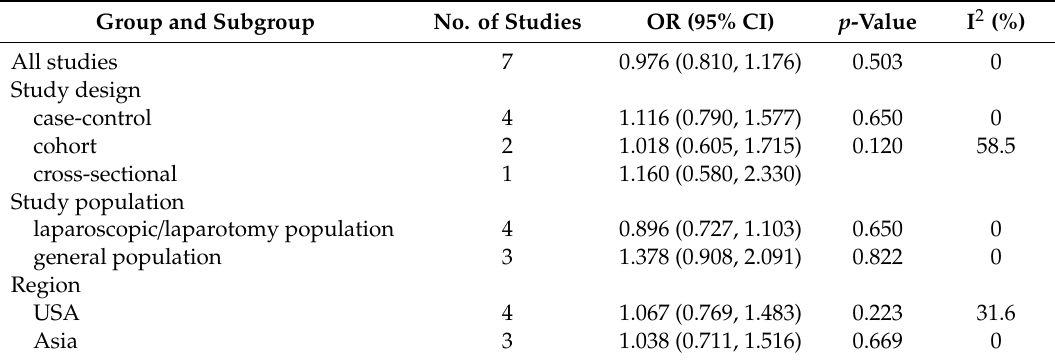
Table 6. Results of the Meta-Analyses of Studies of the Association between monobenzyl phthalate (MBzP) and Endometriosis.